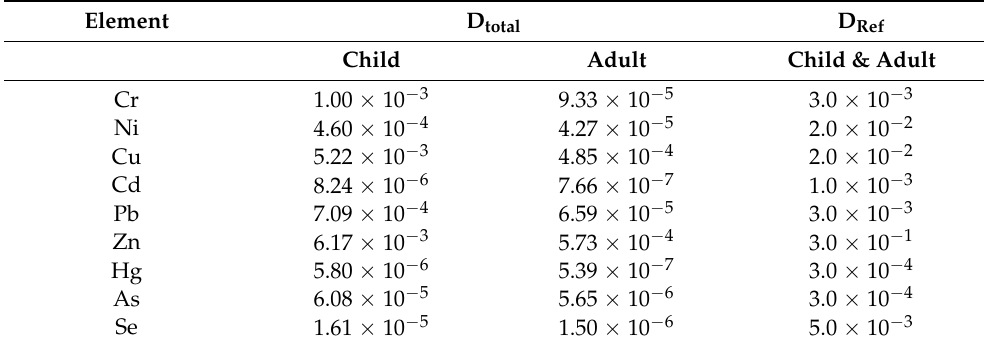
Table 5. Comparison between the total doses for children and their parents with the reference doses. Element